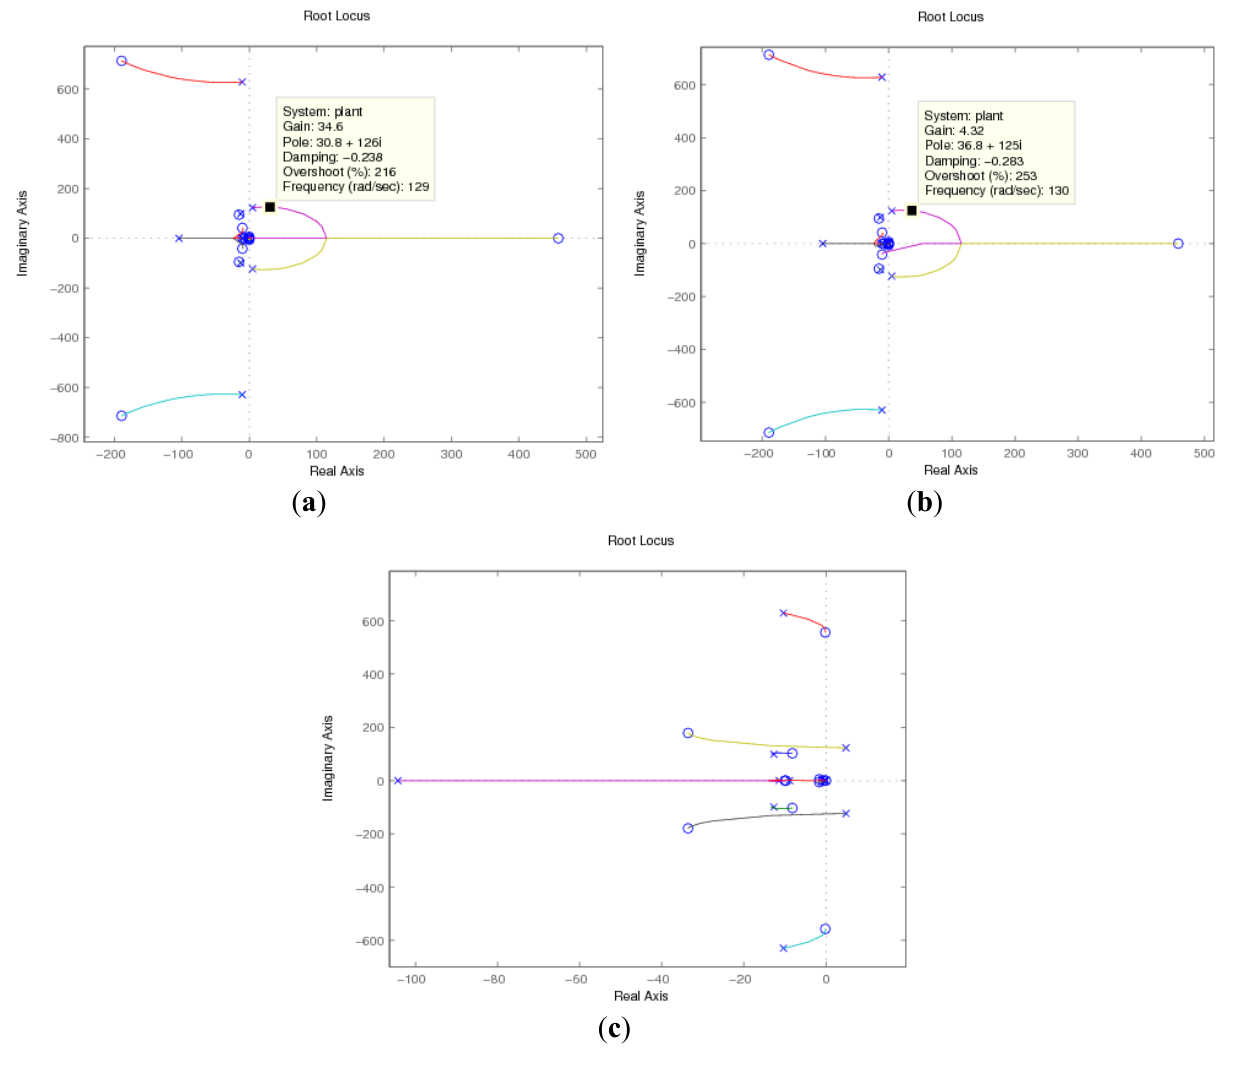
Figure 7. The root locus diagrams of the open loop system with the electrical power as the feedback signal and different modulated-voltage injections ( a ) to the d-axis of the GSC outer loop, ( b ) to the d-axis of the GSC inner loop, and ( c ) to the q-axis of the GSC inner